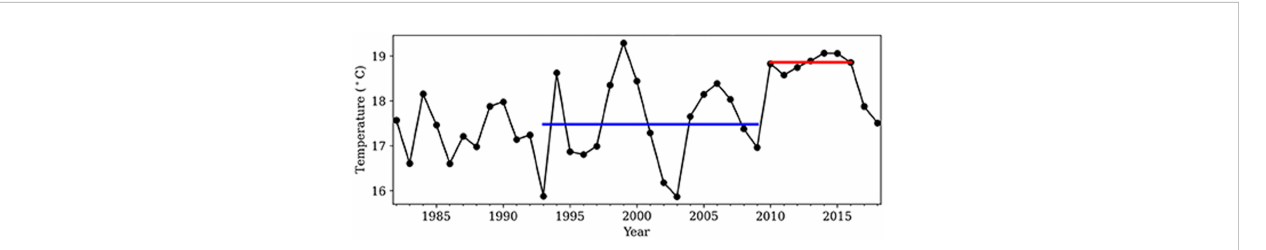
FIGURE 1 Time series of the July – September mean sea surface temperature (°C) from 1982 to 2018 southeast of Hokkaido, Japan (143 – 147°E, 40 – 43°N). The blue line shows the 1993 – 2009 mean; the red line shows the 2010 – 2016 mean. (From Miyama et al.,